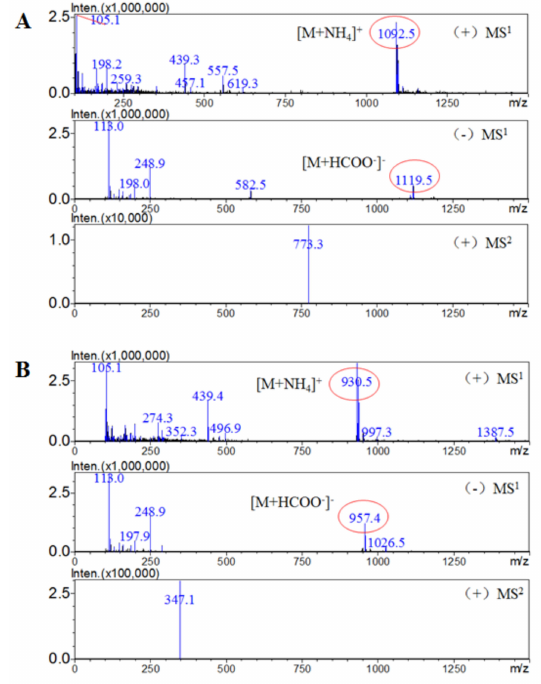
Figure 3. MS 1 and MS 2 spectrum of compounds 1 ( A ) and 2 ( B